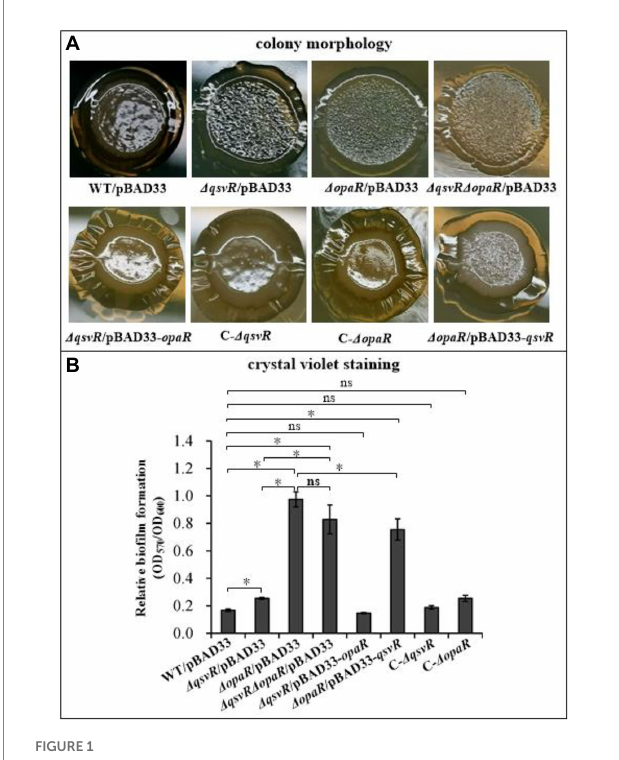
FIGURE 1 QsvR works with OpaR to repress biofilm formation by Vibrio parahaemolyticus . Biofilm formation by V. parahaemolyticus strains was assessed by colony morphology (A) and intensity of crystal violet staining (B) . Photographs are representative of three independent experiments with three replicates each. The asterisks indicate statistical significances ( p < 0.01). The ‘ns’ means no significant differences ( p >